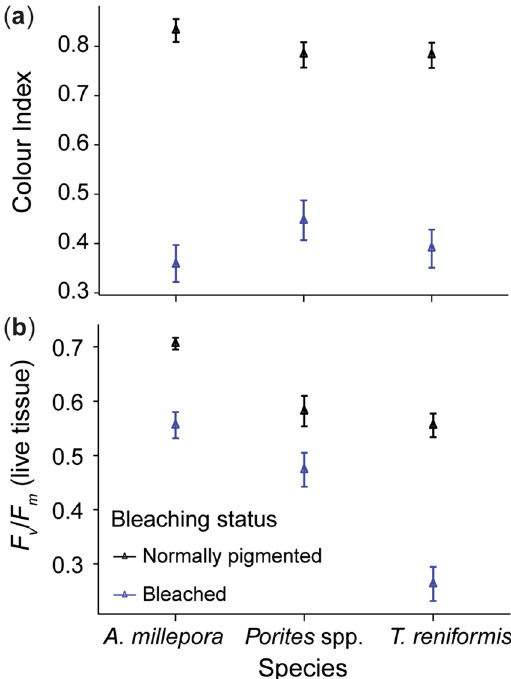
Figure 1. Differences in coral tissue colour and maximum quantum yield of the algal symbionts after the experimental bleaching. ( a ) Colour score index and ( b ) F v / F m of bleached and normally-pigmented corals after exposure to 31 °C or 27 °C for 3 weeks and before the sediment deposition experiments. Average data is presented with SE, n = 48 fragments per bleaching status for each